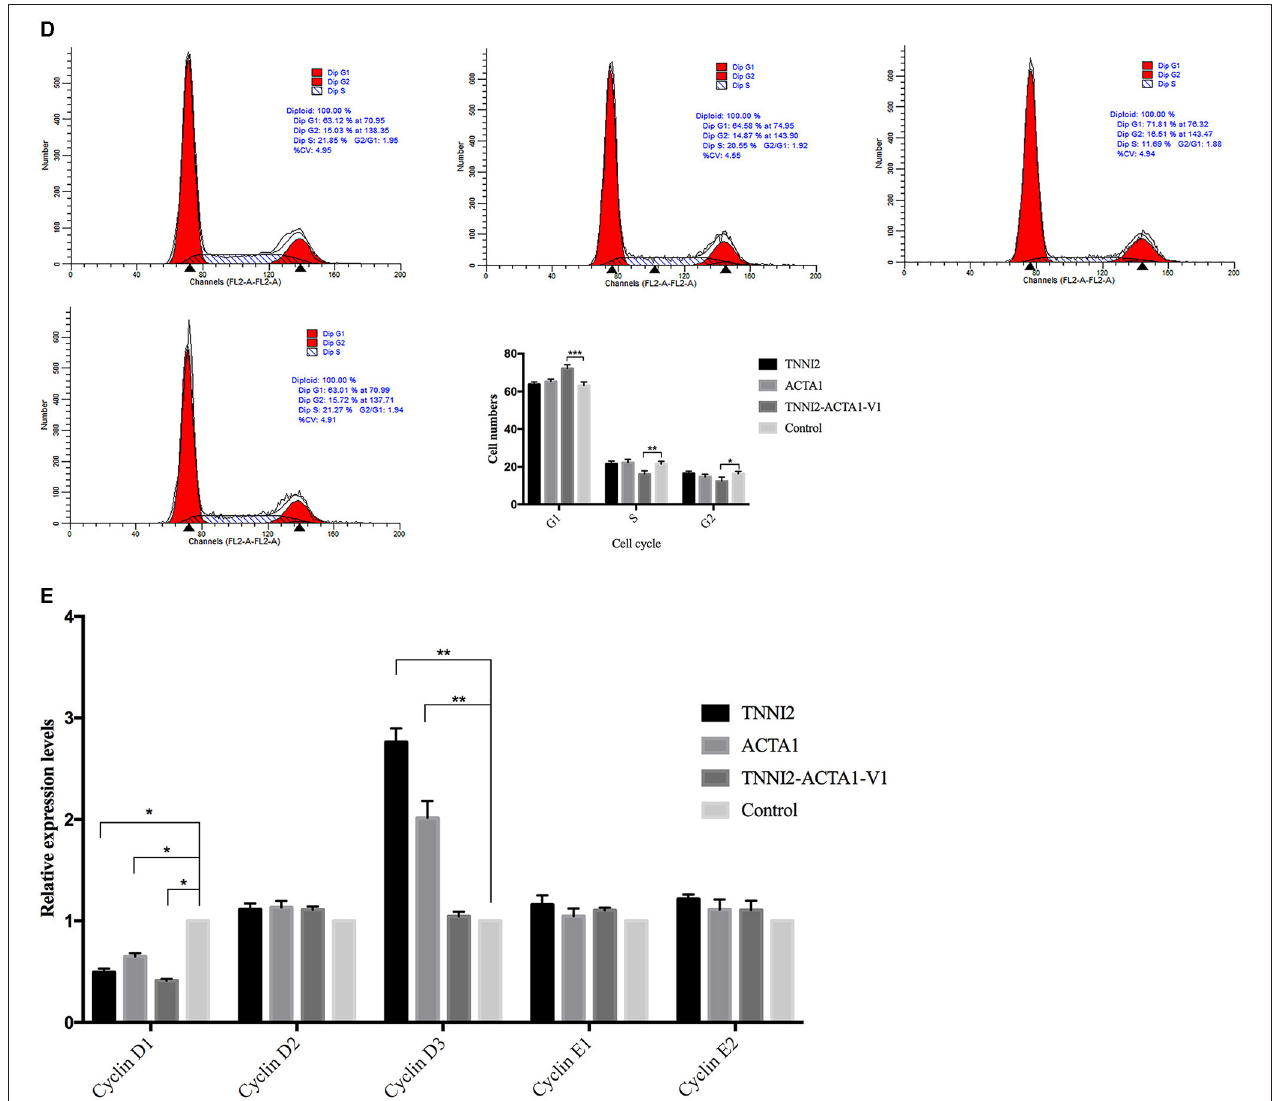
FIGURE 4 | Effects of target fragments on cell proliferation of PSCs. (A) The results of the CCK-8 experiment to detect cell proliferation in 7 days. (B) EdU staining results of PSCs in different groups at 48h posttransfection. (C) The relative percentage of EdU-positive cells in images of related groups is shown. (D) PSCs were transfected with target fragments overexpression plasmids during proliferation. The cells were harvested, and samples were analyzed by flow cytometry at 48h posttransfection. (E) Detection of the variation of related gene expression of G1/S phase by real-time PCR. p < 0.05 was considered statistically significant. * p < 0.05, ** p < 0.01, *** p <